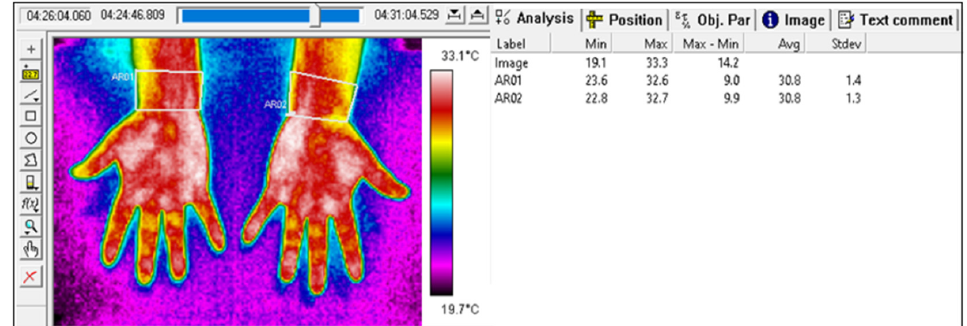
Figure 4. ThermaCAM Researcher Pro 2.10 software display. Table 1 . Scale of the level of attention given according to differences of temperatures between the body ROI (body region of interest) against laterals or between two shots of the same ROI.